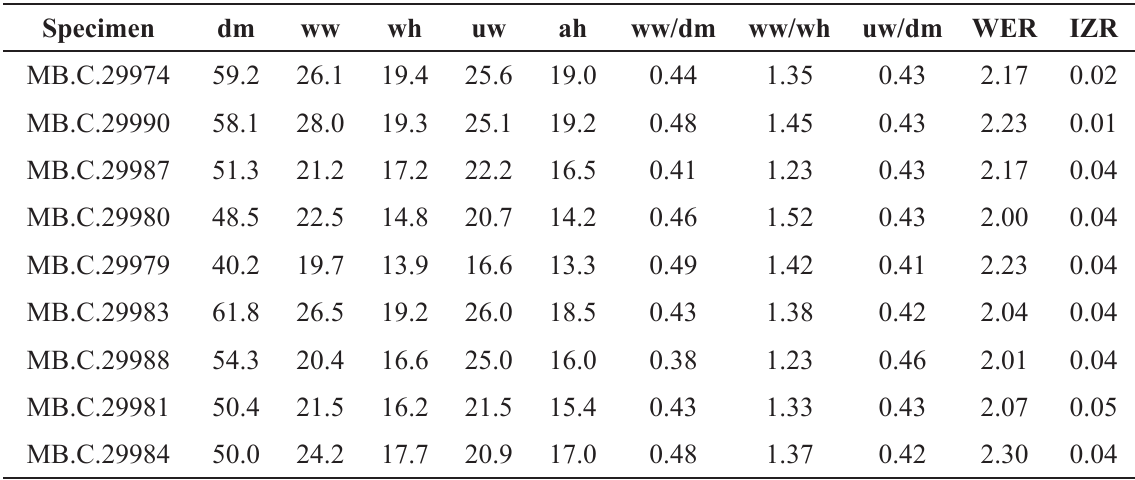
Table 24. Conch dimensions (partly estimated) and ratios of selected specimens of Alibashites ferdowsii Korn & Ghaderi in Korn et al., 2016 from Baghuk Mountain.